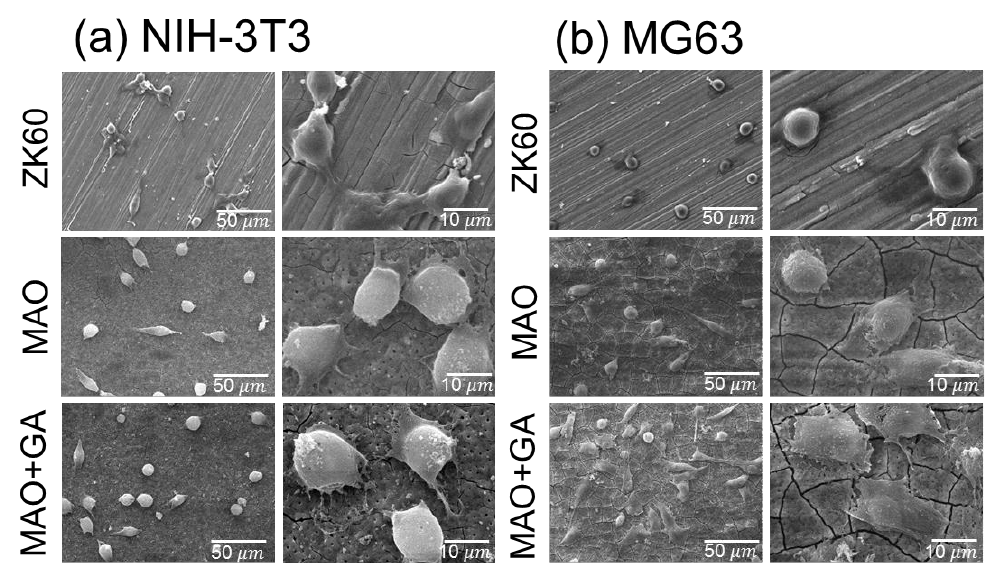
Figure 8. SEM images of ( a ) NIH-3T3 and ( b ) MG63 cells attachment on ZK60, MAO, and MAO+GA.